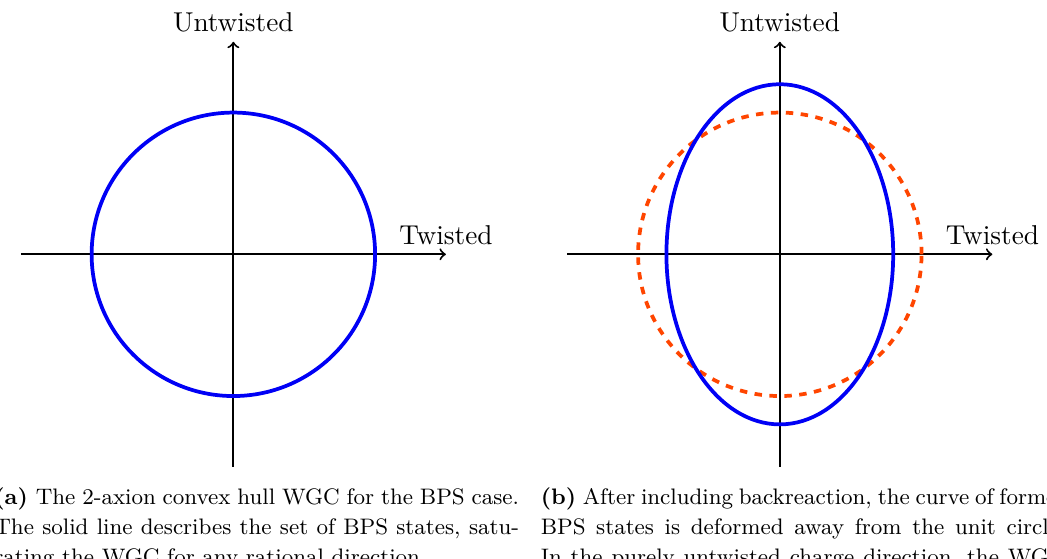
Figure 3. The 2-axion convex hull WGC before and after including